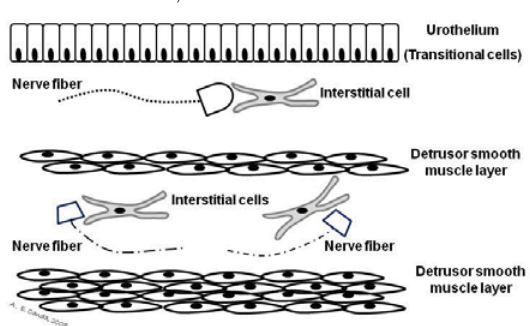
Figure 4. Demonstration of interstitial cells and neural tissue in the lower urinary tract forming a strategic network (i.e. urinary